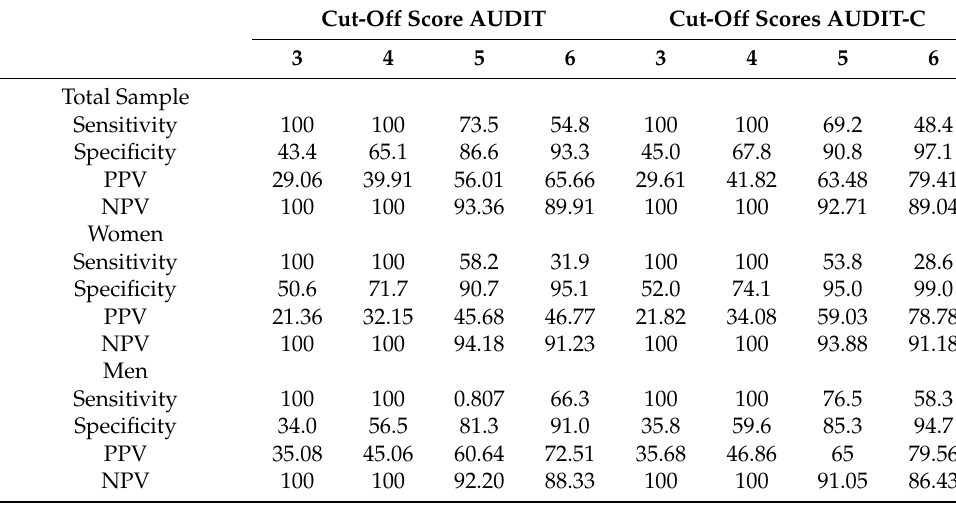
Table 3. Sensitivity, specificity, PPV, and NPV in percentages for different cut-off scores AUDIT and AUDIT-C for the total sample and the male/female